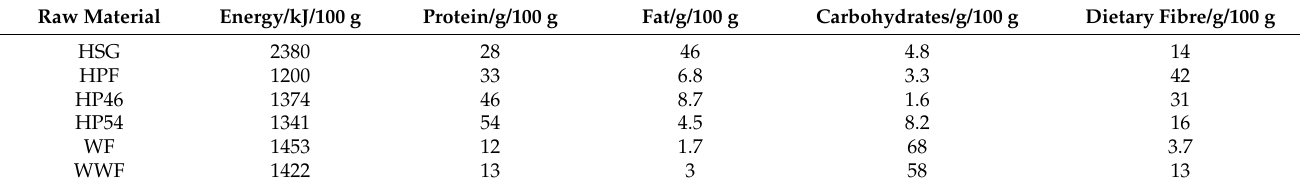
Table 4. Nutritional values of all raw materials according to nutrition labels. HSG—hemp seed grit; HPF—hemp press cake flour; HP46—hemp press cake flour protein (46%); HP54—hemp press cake flour protein (54%); WF—wheat flour; WWF—whole wheat